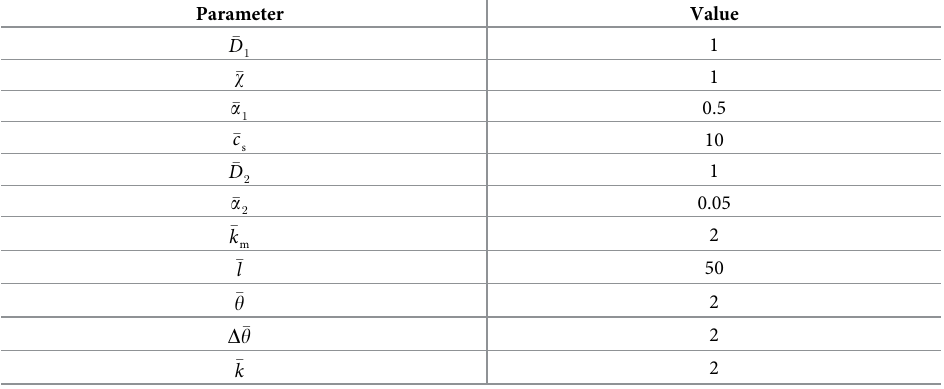
Table 2. Dimensionless model parameters used for data generation. The values are selected to make relevant all bio- logical phenomena.